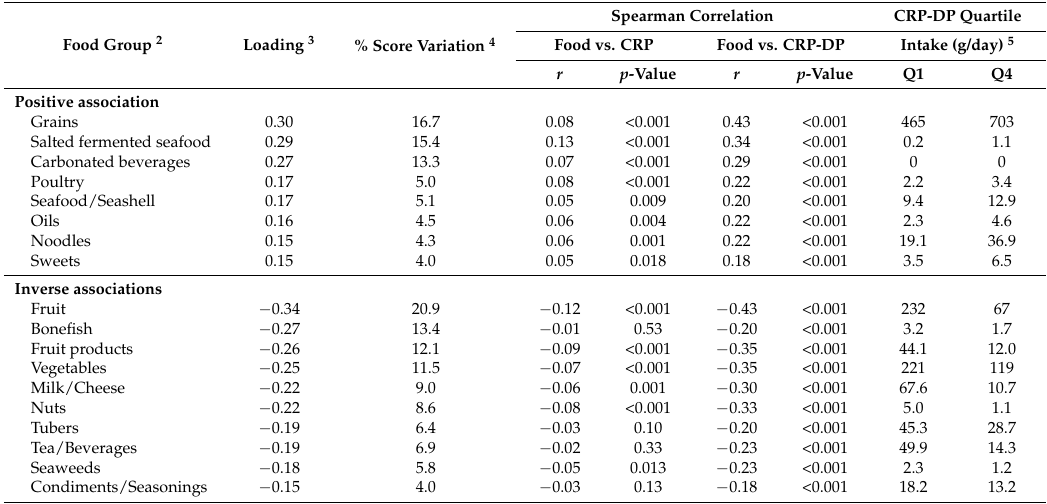
Table 3. Major food groups of the CRP-dietary pattern, and their correlations with CRP concentration and CRP-dietary pattern scores 1 .